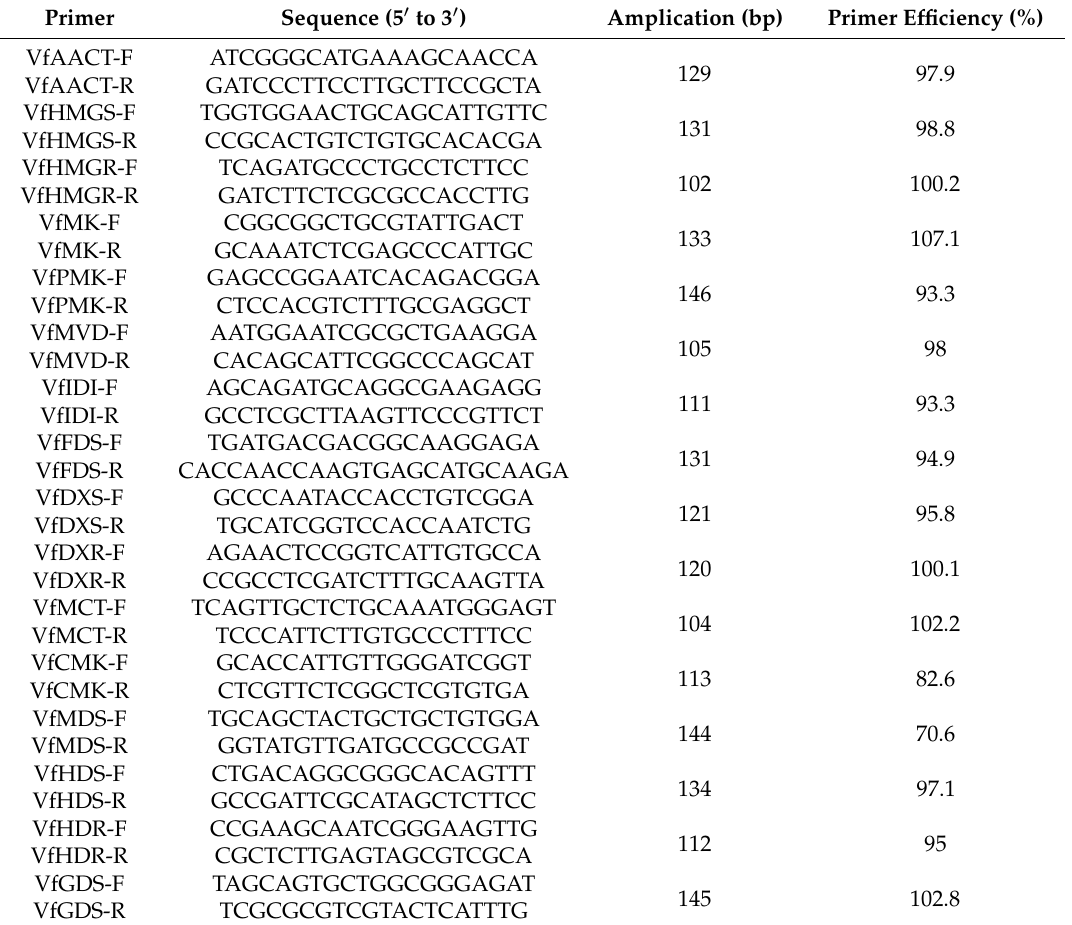
Table A1. Primers sets used in the experiments and their efficiency (%) for qRT-PCR.